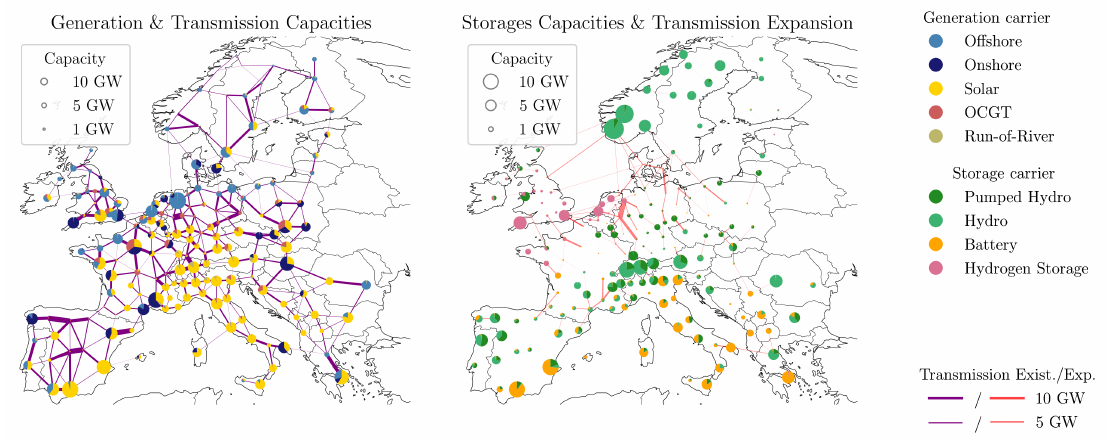
Figure 4. Highly renewable PyPSA-EUR network with 181 nodes, 325 AC lines, and 48 controllable DC links. Two scenarios are investigated, one without network expansion and one with an 18% expansion relative to today’s total transmission